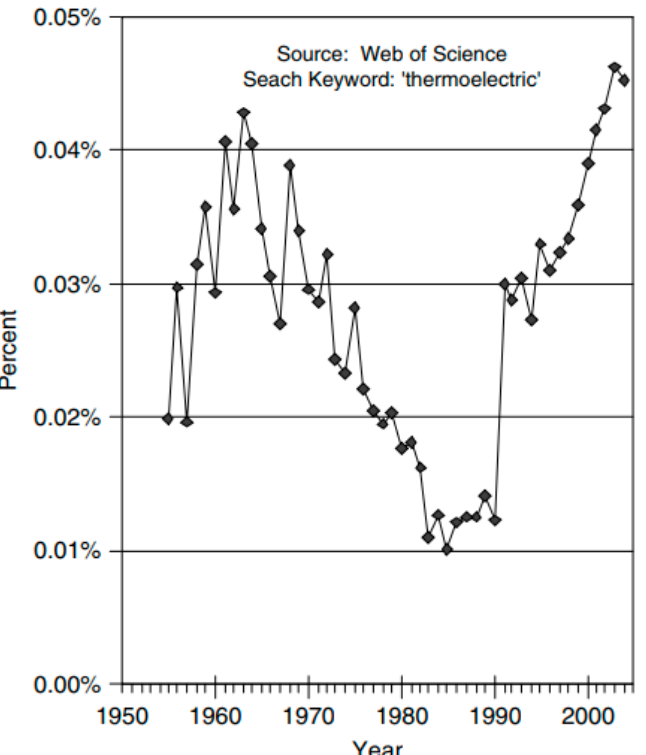
Figure 1. Open literature publications on the Web of Science database with the keyword “thermoelectric” as a percentage of all publications on the database for each year from 1955 to 2003 [20].